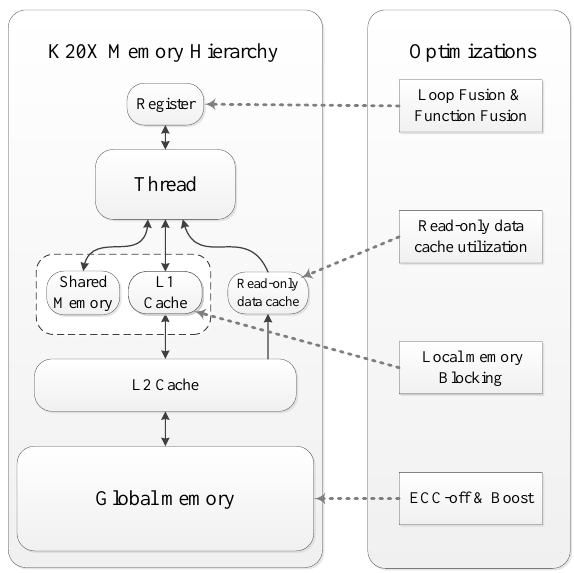
Figure 3. The memory hierarchy of the K20X GPU and the rela- tionships with each